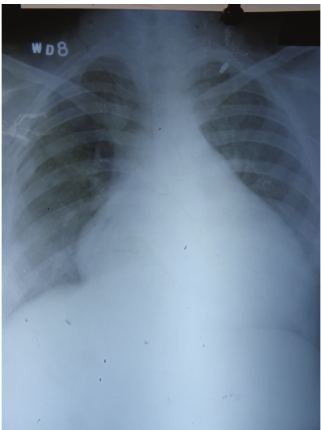
Figure 2: Chest X-ray showing increased cardiothoracic ratio and prominent left pulmonary conus.